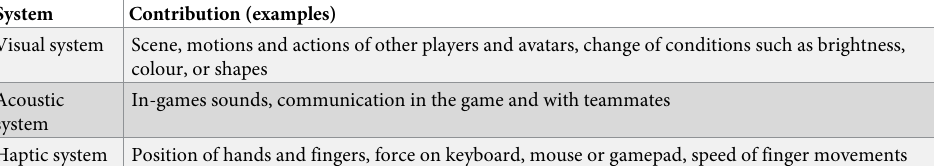
Table 2. Contribution of selected sensory systems to performance in